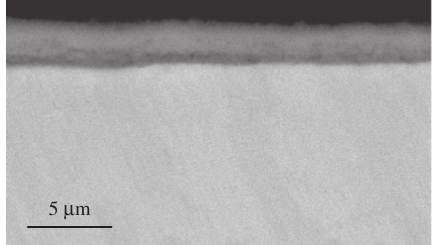
Figure 4: Micrograph (SEM/BEI) of a cross section of Ti-5Al-2.5Sn oxidized in air at 650°C for 24 h.